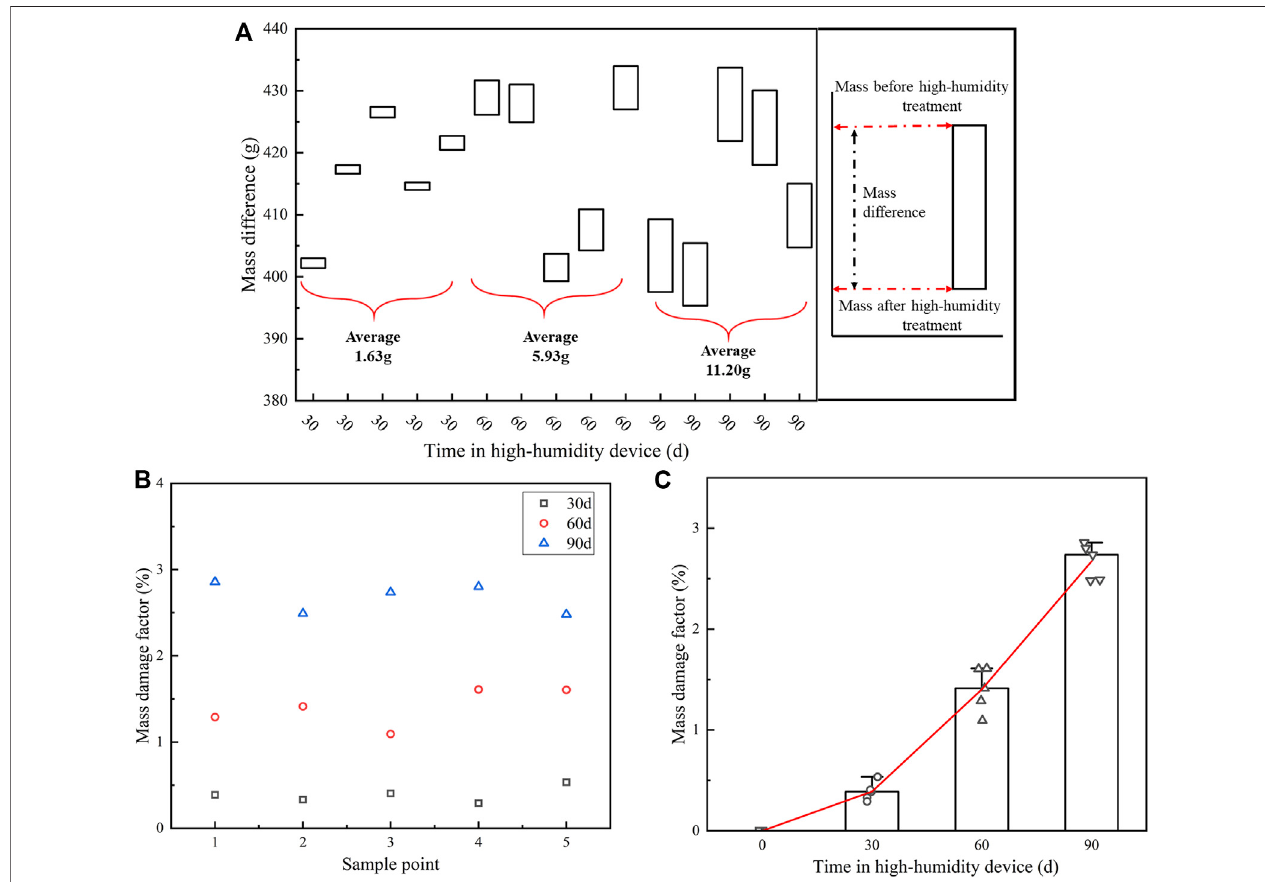
FIGURE 6 | Comparison of mass damage of dolomite at different time nodes under high-humidity action: (A) Mass damage of each sample; (B) Mass damage factor of each sample; (C) Mean and error of mass damage factors at each time node.